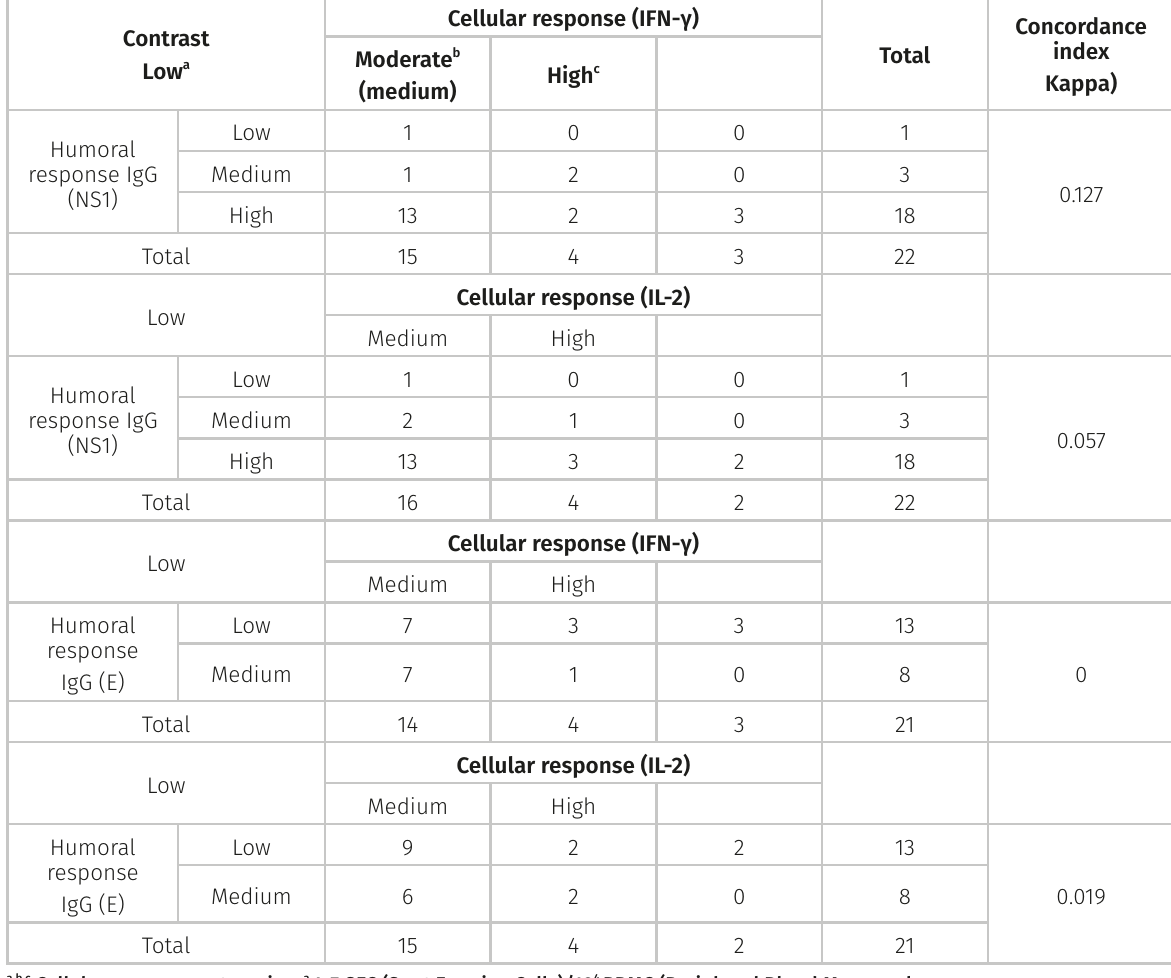
Cellular response (IFN-γ)